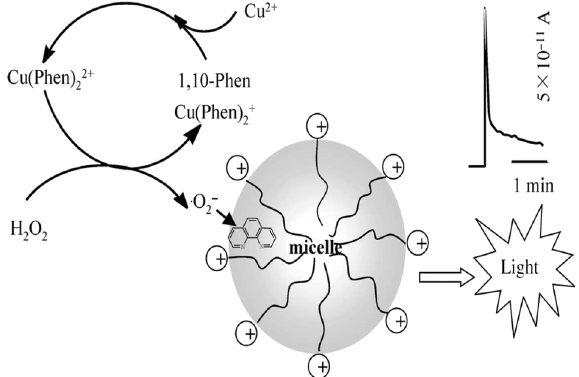
Figure 4: CL mechanism of 1,10-phenanthroline-Cu(II) system in micellar medium. Reprinted with permission from Lin and Yamada